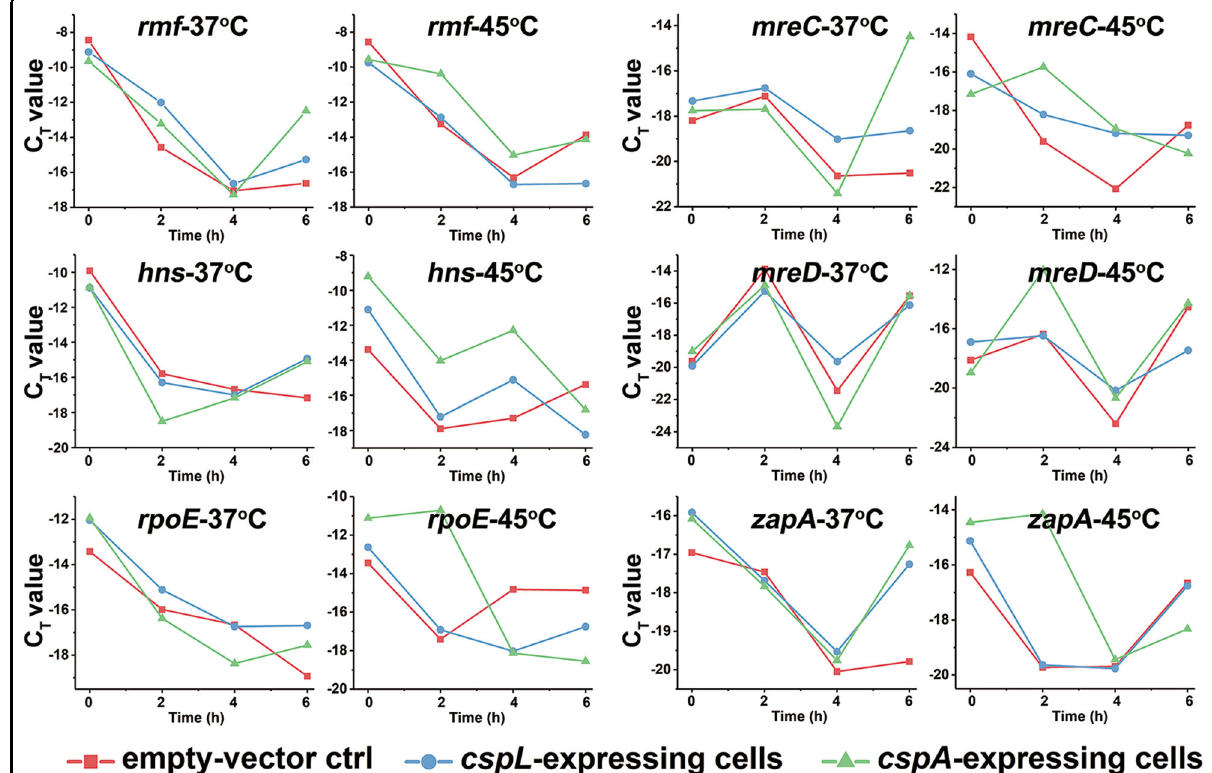
Fig. 5 mRNA degradation ratios. Different mRNA degradation ratios show different binding preferences for CspL and